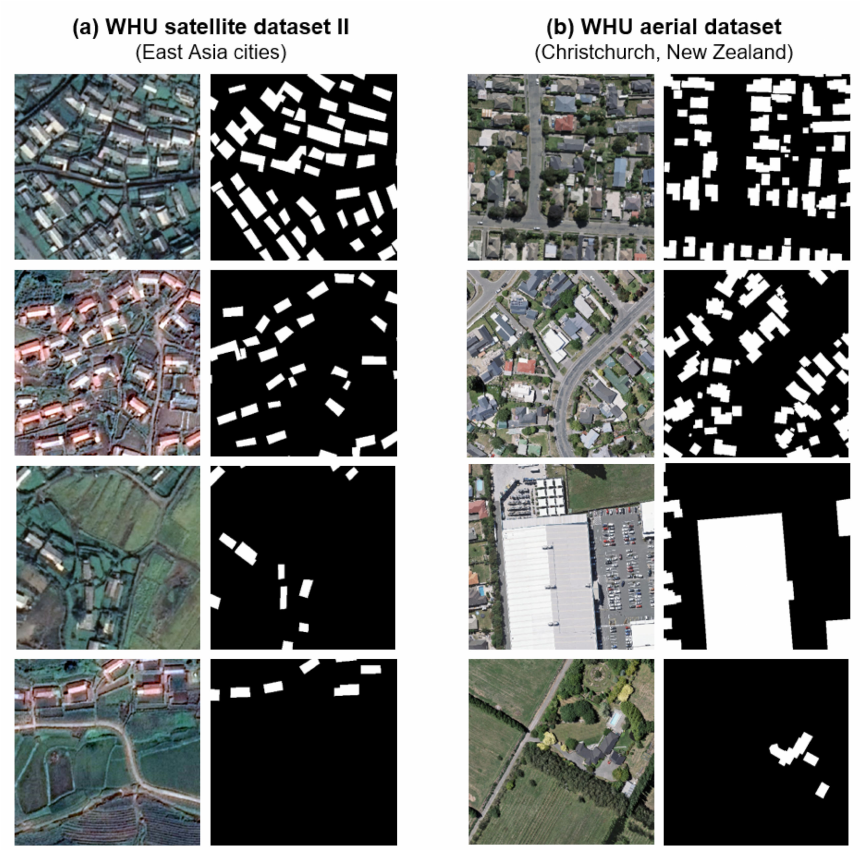
Figure 2. Illustration of image–label pairs in WHU satellite dataset II covering East Asia cities ( a ) and WHU aerial dataset covering Christchurch, New Zealand ( b ). For each dataset, the first column presents the RGB image with 512 × 512 pixels, and the second column presents the labels with white building